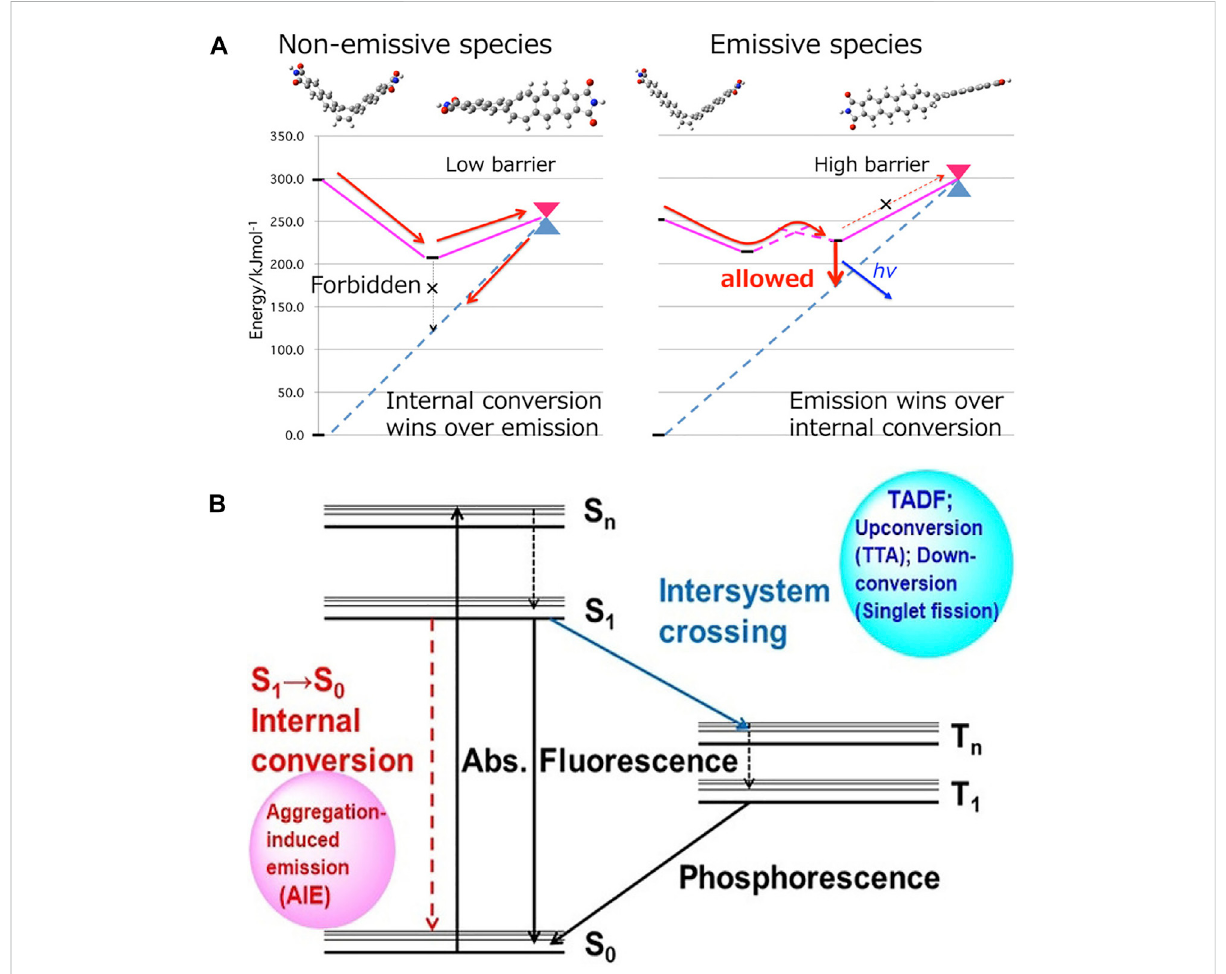
FIGURE 2 (A) Schematic illustration of the conical intersection accessibility in dilute solution (left) and aggregates (right) (Suzuki et al., 2015). (B) Jablonski diagram of an atypical organic fl uorophore (Suzuki et al.,